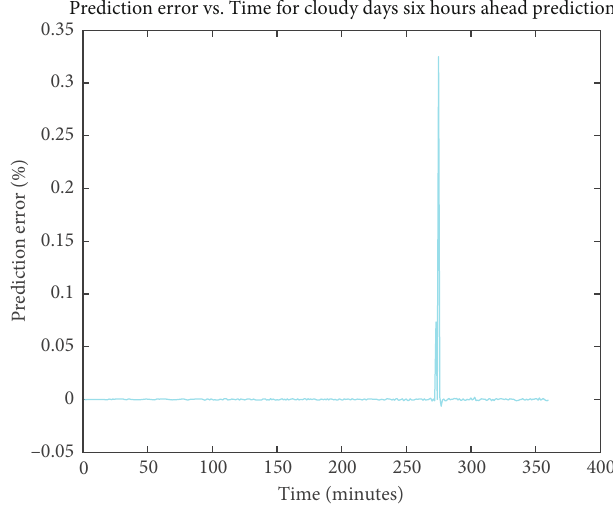
Figure 38: Prediction error vs. time for cloudy day six-hour-ahead prediction.